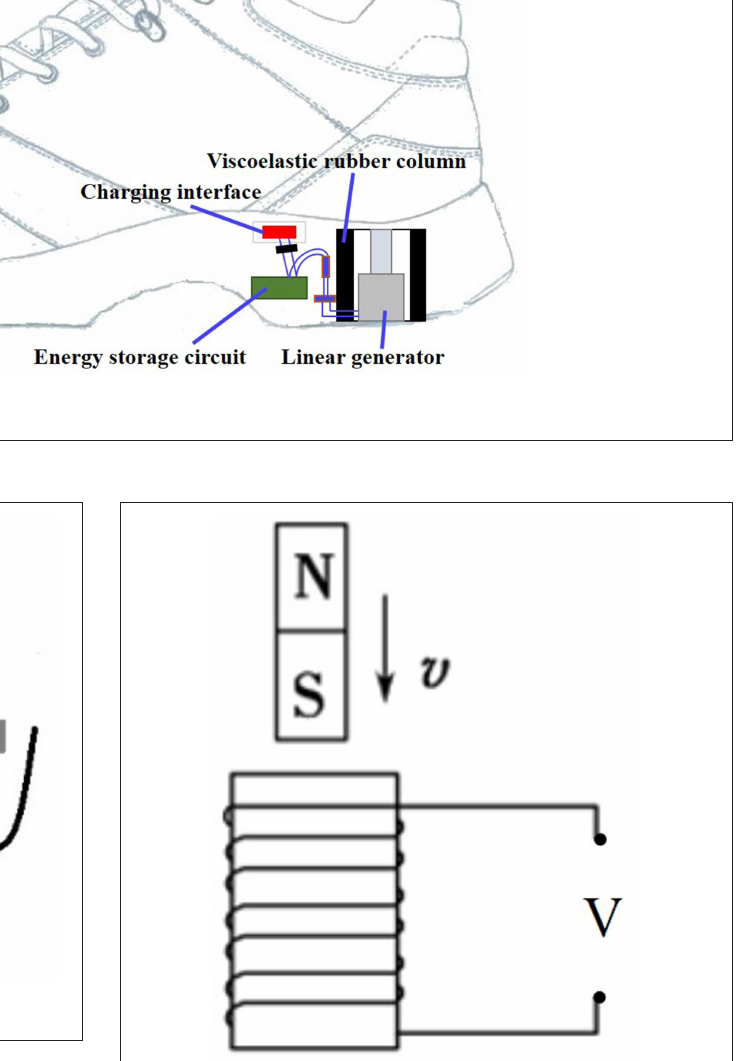
FIGURE 3 | The in-shoe energy harvester structure